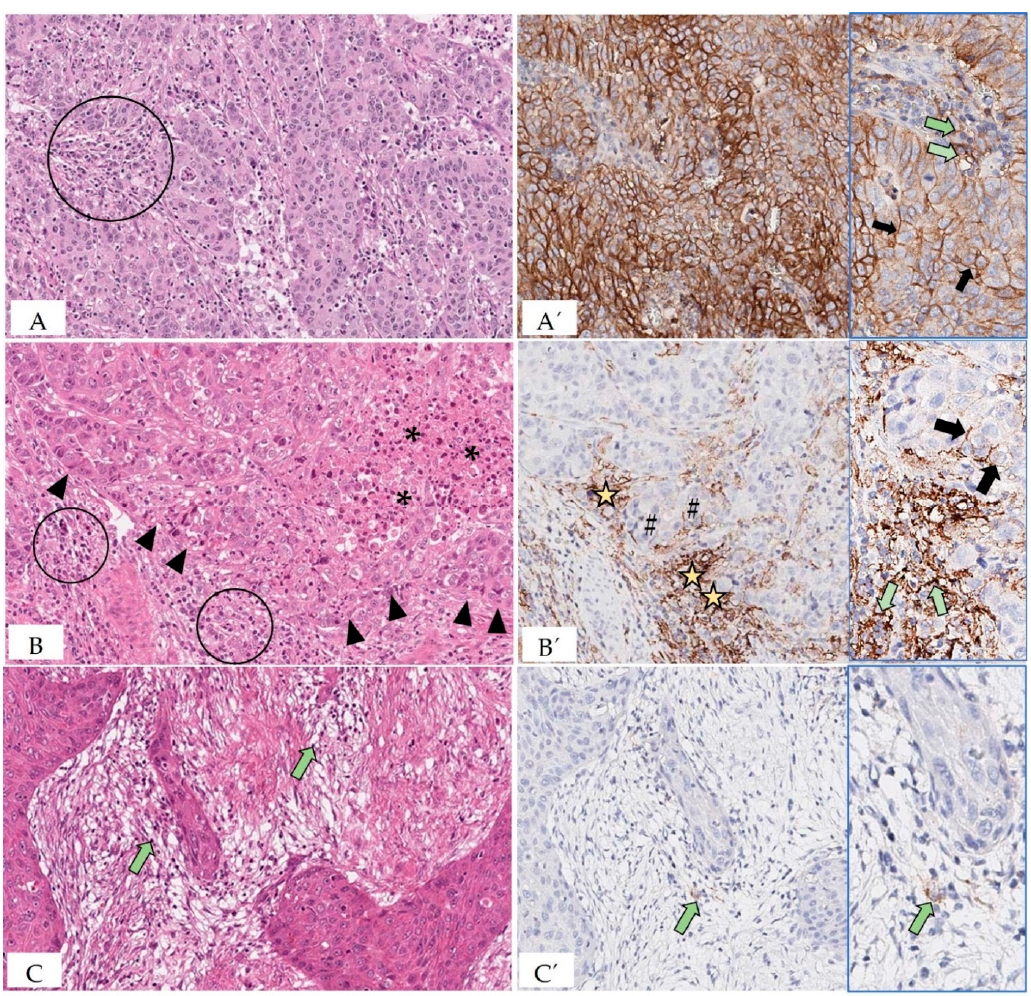
Figure 4. Depicted are representative areas of sections of human carcinomas that are stained with hematoxylin–eosin ( A – C ) and immunolabeled for PD-L1 ( A’ – C’ ). Immunostaining was performed with PD-L1 IHC 22C3 pharmDx for Autostainer Link 48 and DAB as chromogen. A (carcinoma of the gastro-esophageal junction): The scarce tumor stroma contains mild to moderate numbers of tumor-infiltrating lymphocytes (TILs; circle). 20×. A´ : All tumor cells show linear partial to complete moderate to strong membranous staining consistent with constitutive PD-L1 expression through the oncogenic pathway. 20×. Inset: Shown in greater detail is the membrane staining of tumor cells (black arrows). In addition, a few TILs have membranous to cytoplasmic PD-L1 expression (green arrows). B (esophageal carcinoma): The tumor stroma is infiltrated with moderate TIL numbers (circles). The interface between stroma and tumor cell nests is demarcated by arrowheads. An area of necrosis is marked by asterisks. 20×. B´ : PD-L1-positive immune cells accumulate at the interface between tumor cell nests and stroma (stars). The PD-L1 staining of tumor cells is restricted to those that are located at the periphery of the tumor cell nests in immediate proximity to the PD-L1-positive immune cells (hash signs). This staining pattern is consistent with adaptive induced PD-L1 expression. 20×. Inset: In higher magnification are depicted aggregates of PD-L1-positive immune cells that show a strong membranous to cytoplasmic staining (green arrows). The partial to complete membranous staining (usually of a weaker intensity compared to the adjacent immune cells) of the cancer cells is marked by black arrows. 40×. C (carcinoma of the gastro-esophageal junction): The tumor stroma is infiltrated by only a few TILs (green arrows). 20× C’ : Tumor cells are PD-L1 immunonegative, whereas very few immune cells are PD-L1-positive (green arrow). 20×. Inset: The PD-L1-positive immune cell (green arrow) is depicted at higher magnification.